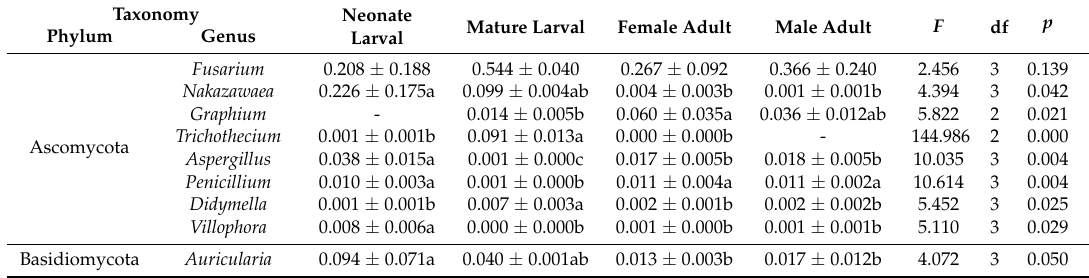
Table A1. The relative abundance of the different fungal taxa in different development stages of T. klimeschi at the genus